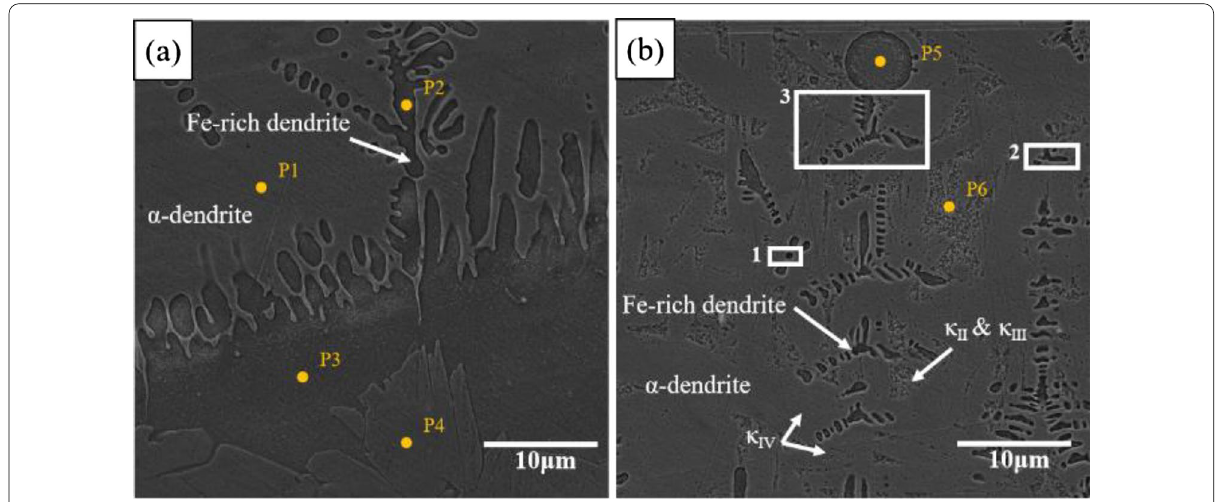
Figure 7 Typical microstructure of a zone 1 and b zone 2 of S1